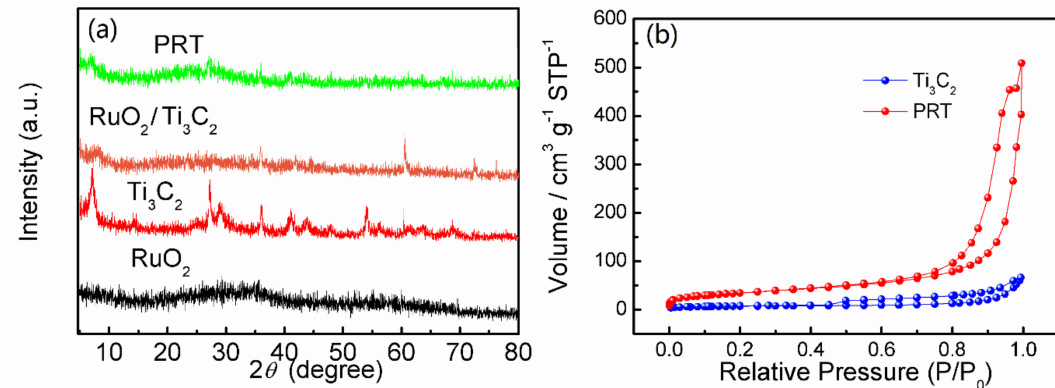
Figure 2. ( a ) X-ray diffractometry (XRD) patterns of RuO 2 , Ti 3 C 2 , RuO 2 /Ti 3 C 2 and PRT; ( b ) BET nitrogen adsorption–desorption isotherms.